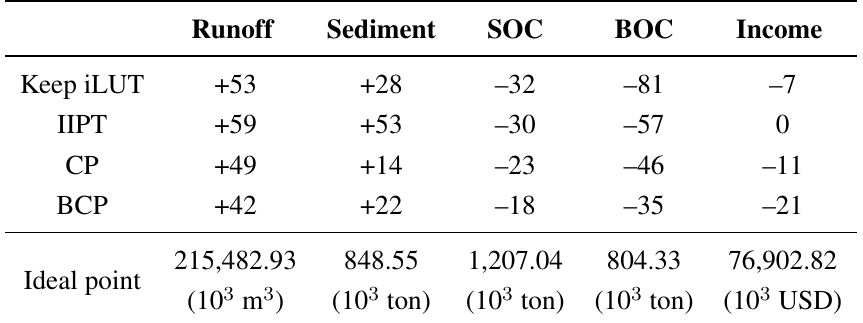
Deviation (%) from the ideal point corresponding to continuing the iLUT or implementing the LUT distribution suggested by IIPT, CP or BCP.